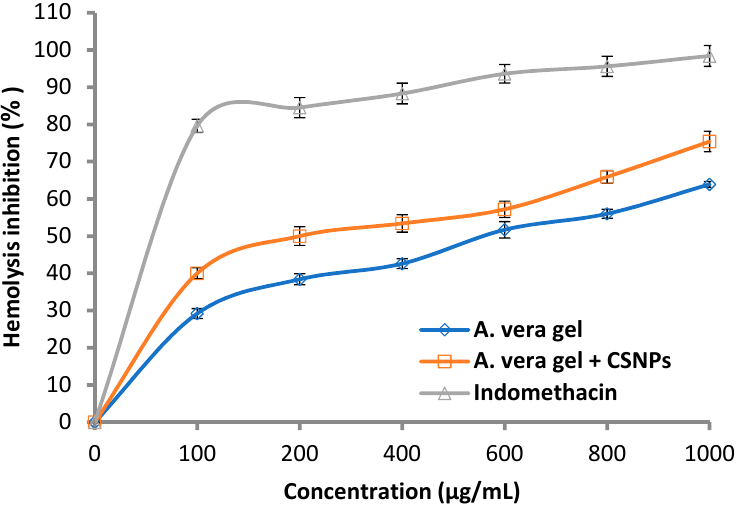
Figure 10. Hemolysis inhibition (%) of A. vera gel, A. vera gel incorporated with CSNPs, and in- domethacin.